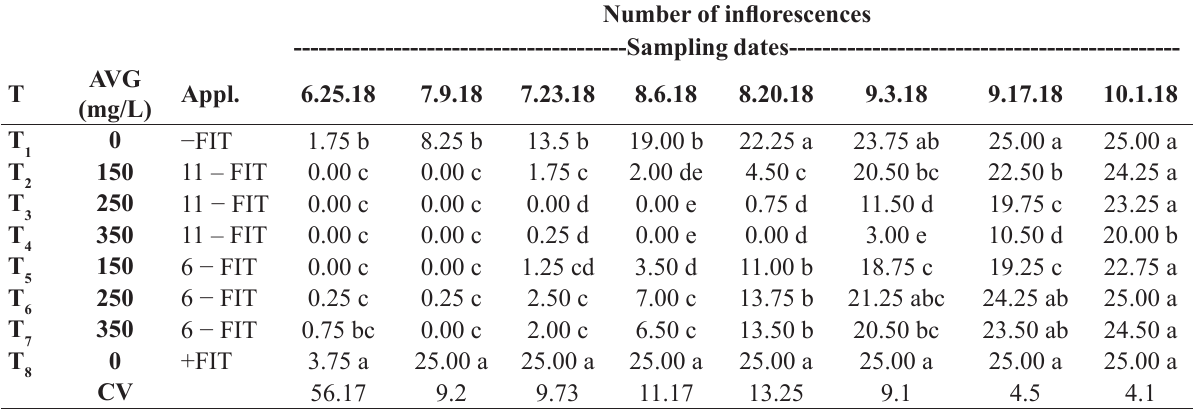
Table 2. Number of inflorescences observed in response to Aviglycine application on pineapple cv. ‘MD2’.